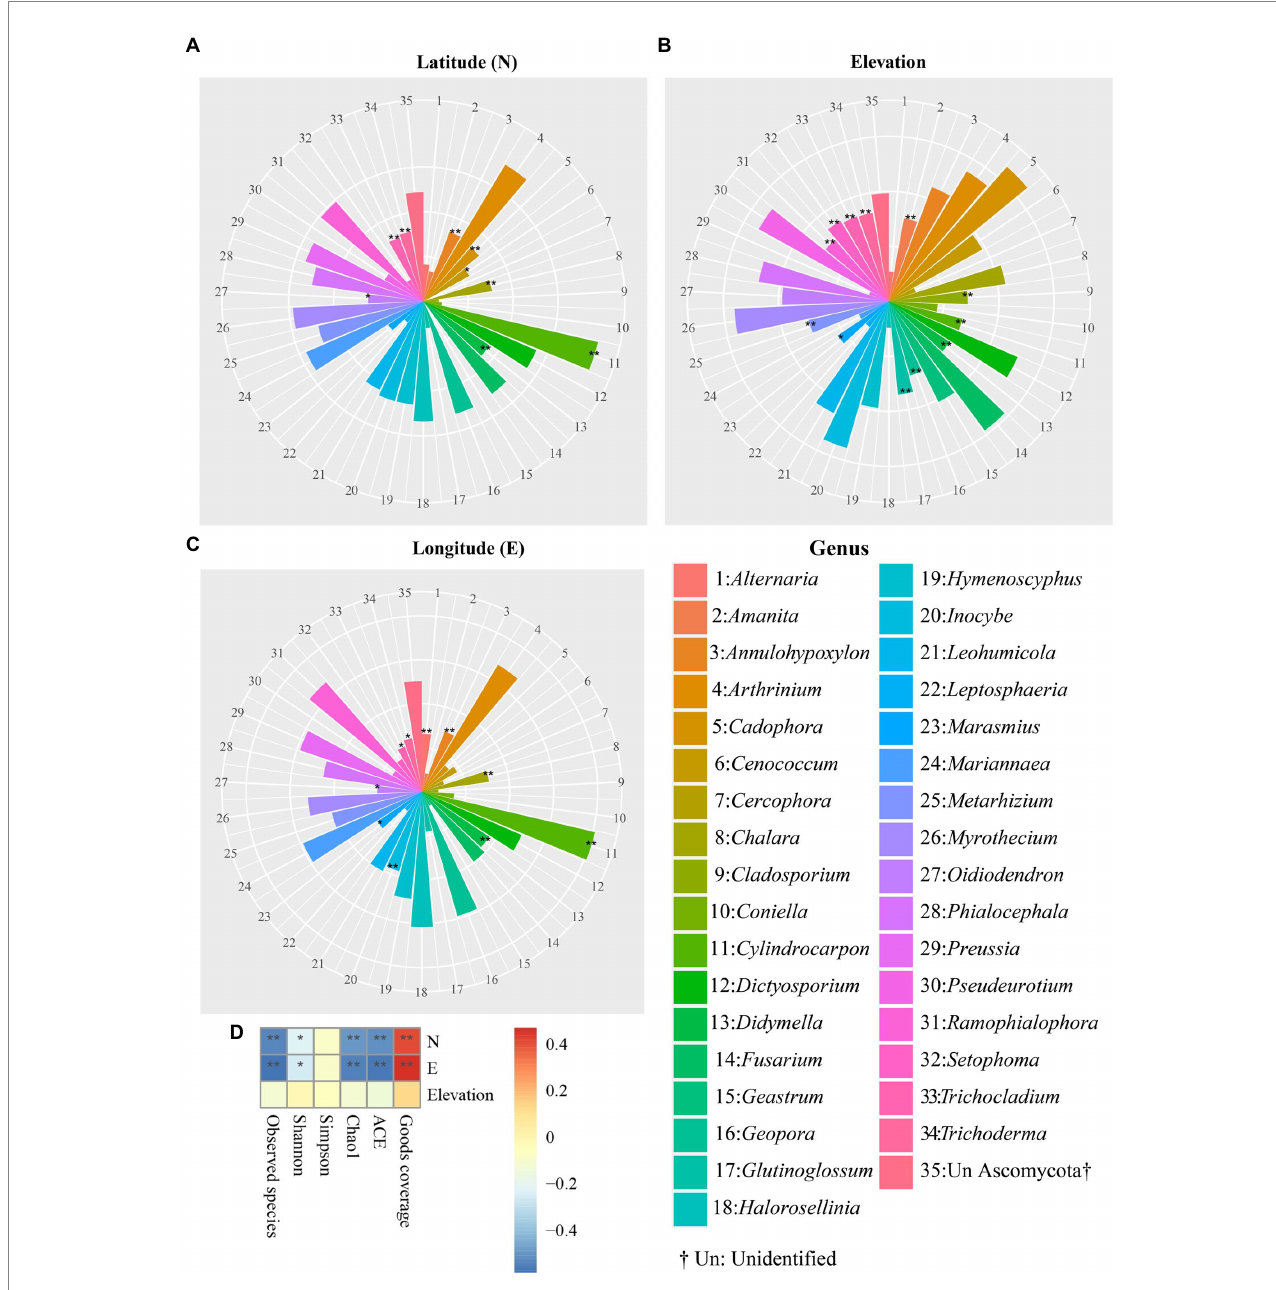
FIGURE 5 The correlation between geographical coordinates and predominant genera. Congruence of abundant fungal genera with latitude (A) , elevation (B) , longitude (C) , and alpha diversity indices (D) . The correlation heatmap was used to show the relationship between abundant fungal genera and GPS information by evaluating the correlation coefficient between each fungal genus with each GPS coordinate. Asterisks denote statistically significant Spearman analysis * and ** represent p -values ≤ 0.05 and 0.01, respectively. The deepest blue ( − 0.4) and red (0.4) represent the negative and positive congruence of alpha diversity parameters with GPS coordinates,